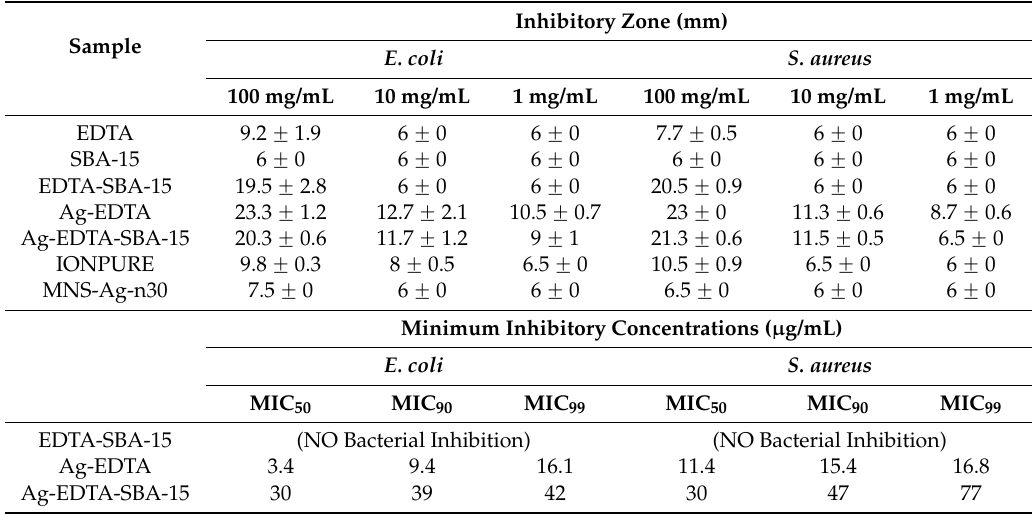
Table 3. Inhibitory zones (mm) of discs and minimum inhibitory concentrations (MICs) of